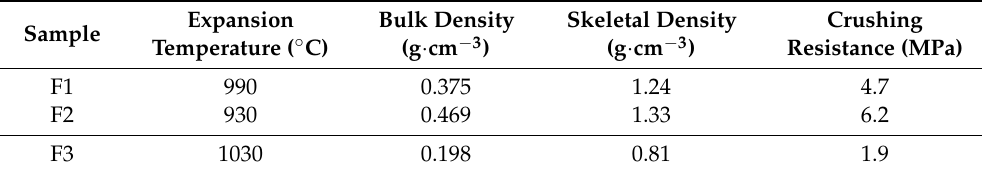
Table 1. Expansion temperature, density, and crushing resistance of three produced microsphere grades.